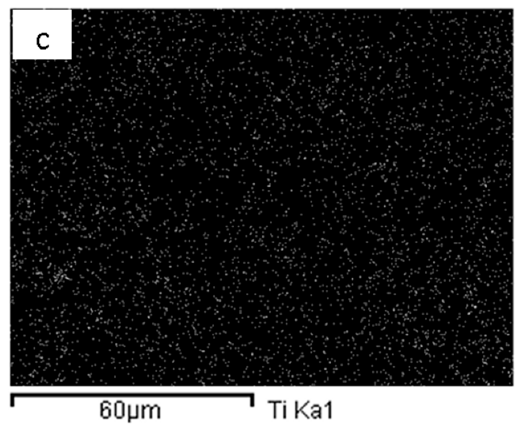
Figure 6. EDS images of TiO 2 ‐ LDPE pellet. Distributions of ( a ) C, ( b ) O, and ( c ) Ti.